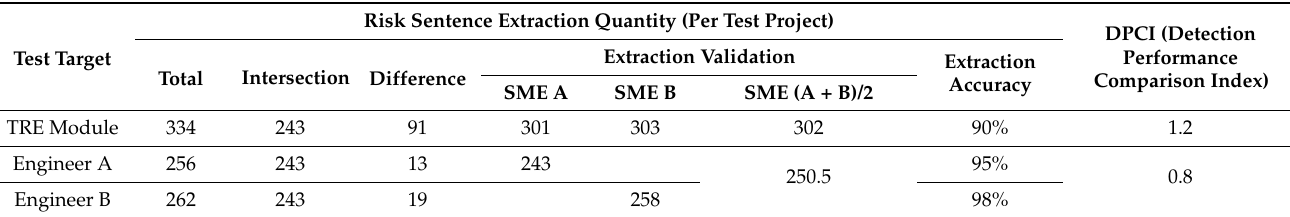
Table 8. The accuracy results of the TRE module’s risk sentence extraction.